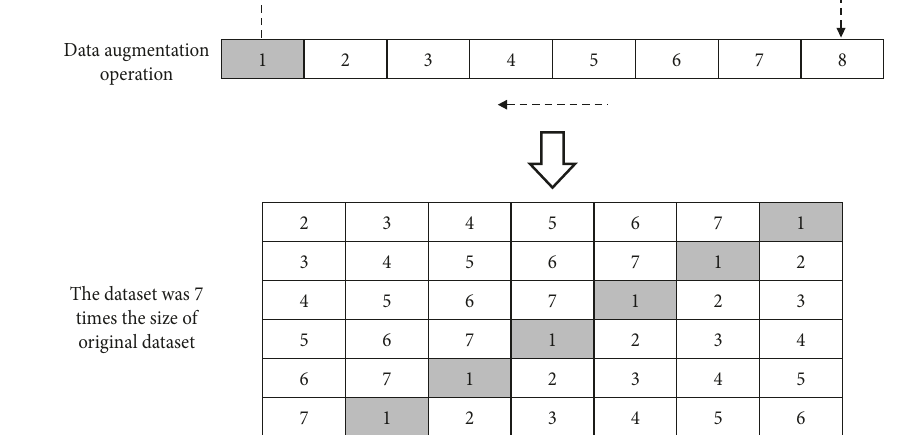
Figure 15: Data augmentation operation.